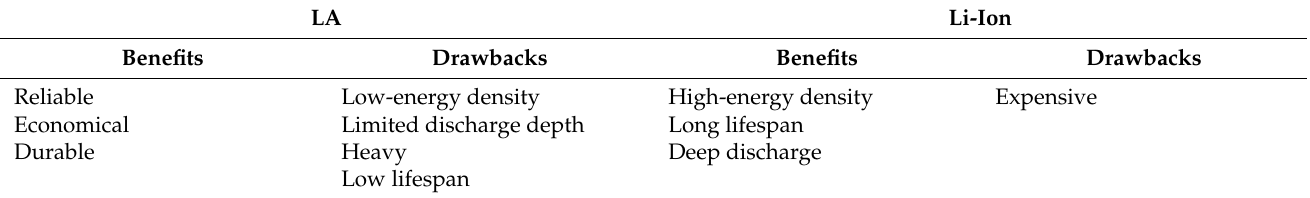
Table 1. Advantages and disadvantages of LA and Li-ion batteries.